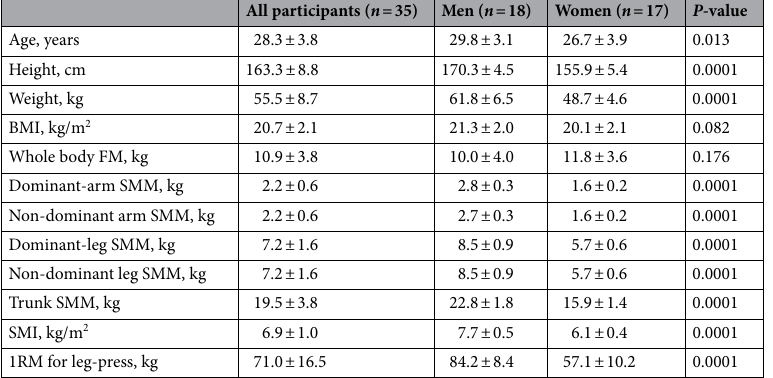
Table 1. Participants’ characteristics. Data are presented as the mean ± standard deviation. 1RM one- repetition maximum, BMI body mass index, FM fat mass, SMI skeletal muscle mass index, SMM skeletal muscle